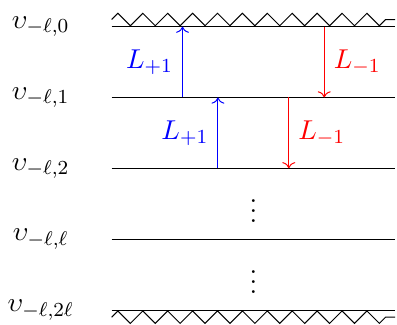
Figure 1 . The finite-dimensional highest weight representation of SL (2 , R ) whose elements solve the near zone equations of motion for a massless scalar field in the Schwarzschild black hole background with multipolar index ‘ and contains the regular static